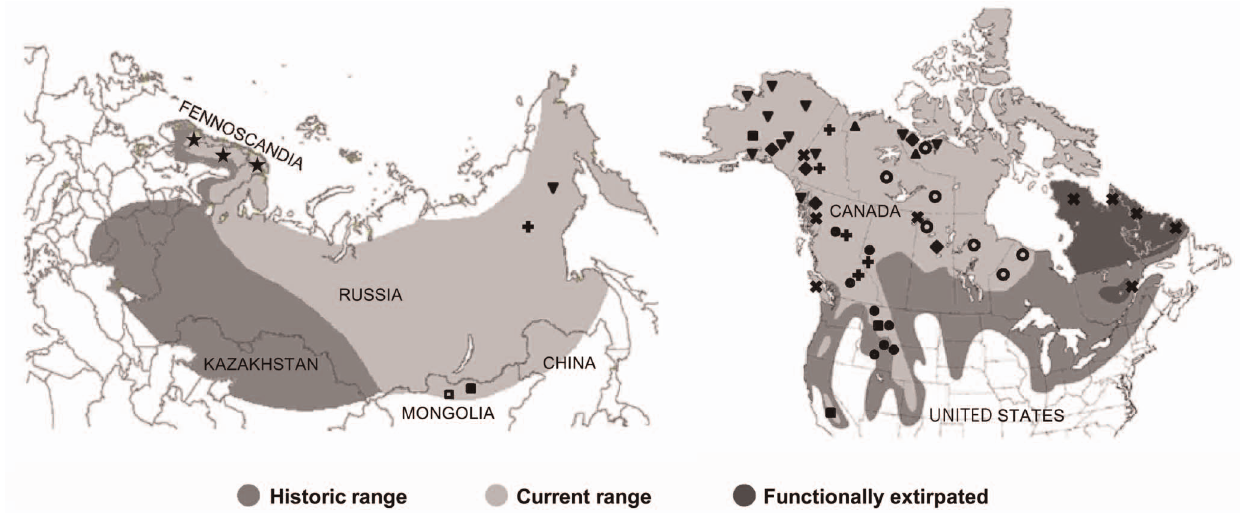
Figure 1. Historic and contemporary Holarctic distribution of wolverines and sampling localities. Historic and current distribution of wolverines in Eurasia (adapted from National Geographic Society [116]) and North America (adapted from COSEWIC [115]), and sampled localities from Wilson et al. [45] - triangle ; Walker et al. [15] - star ; Tomasik and Cook [55] - inverted triangle ; Cegelski et al. [49] - solid circle ; Schwartz et al. [60] - solid square ; Frances [59] - diamond ; Zigouris et al. [51] - open circle ; Rochnov and Meschersky unpub. - open square ; New contemporary samples - plus sign ; and New historic samples - x symbol .